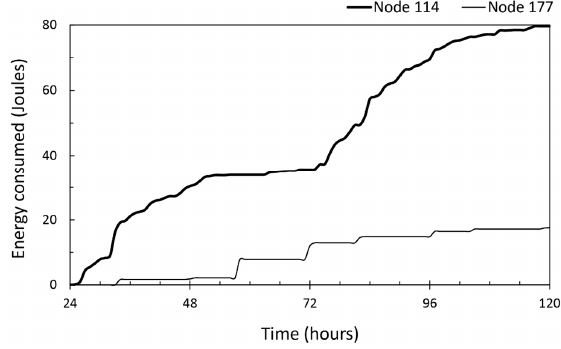
Figure 18. Energy consumption on Node 114 and Node 177.